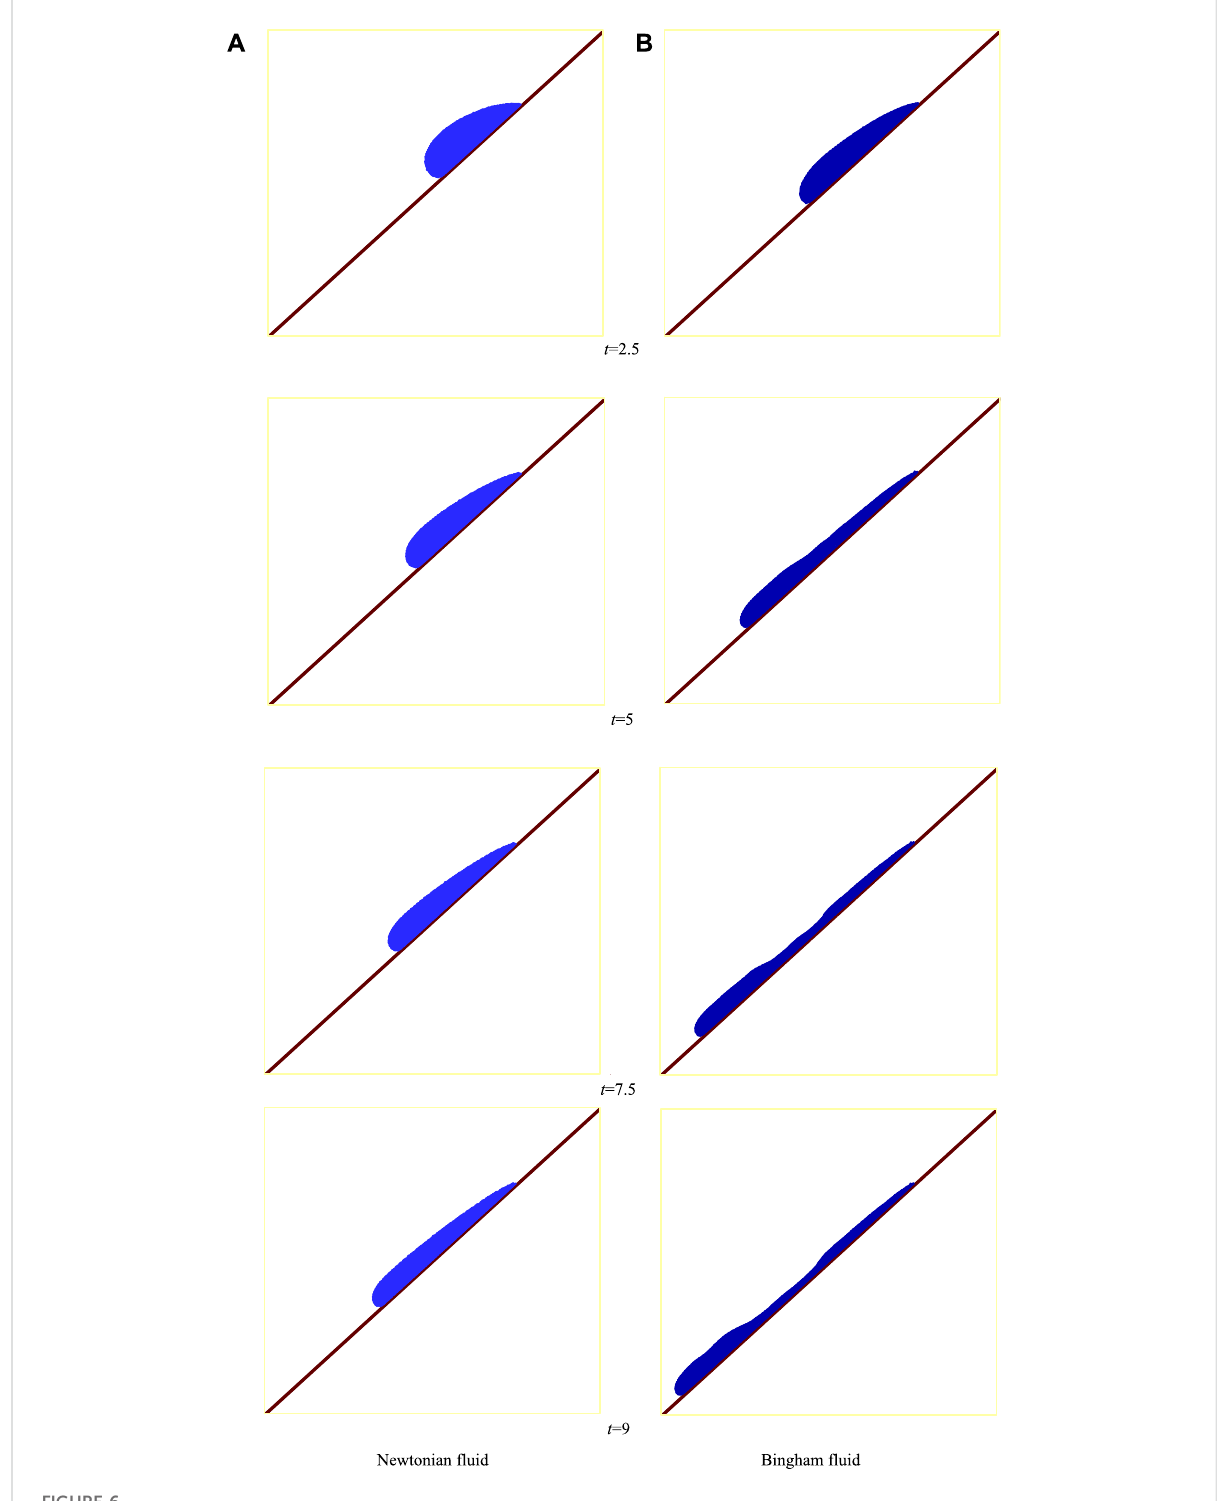
FIGURE 6 Fluid fl ow on a slope: (A) Newtonian fl uid and (B) Bingham fl